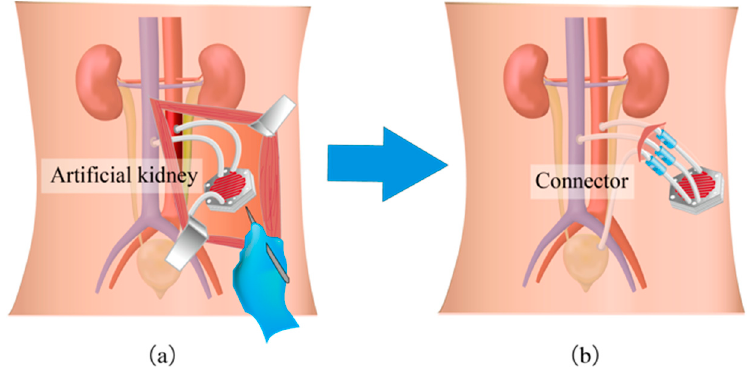
Figure 1. Maintenance surgery of the artificial kidney ( a ) without and ( b ) with the connecting system. It allows the device to be replaced while the connections between the artificial vessels and the artery, vein, and bladder are maintained. The surgery can be less invasive and easier by implanting the device at the shallow region beneath the skin.